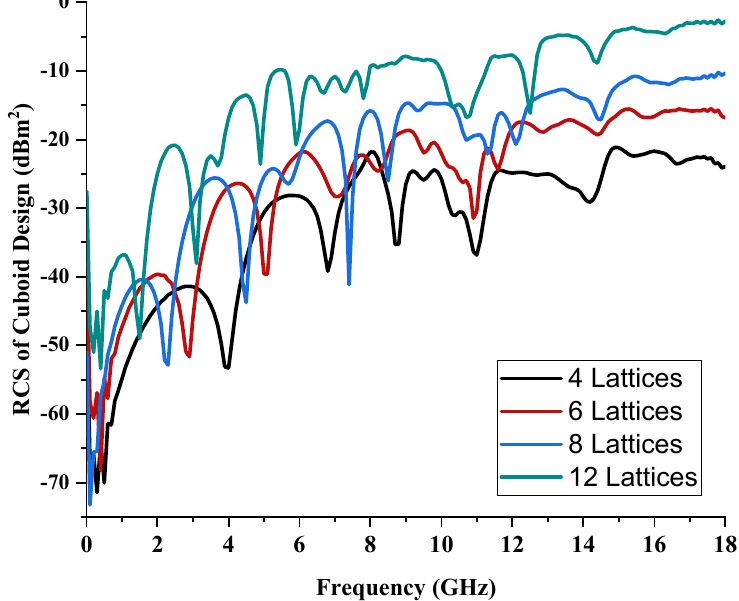
Figure 14. Monostatic RCS data of one-bit cuboid design.